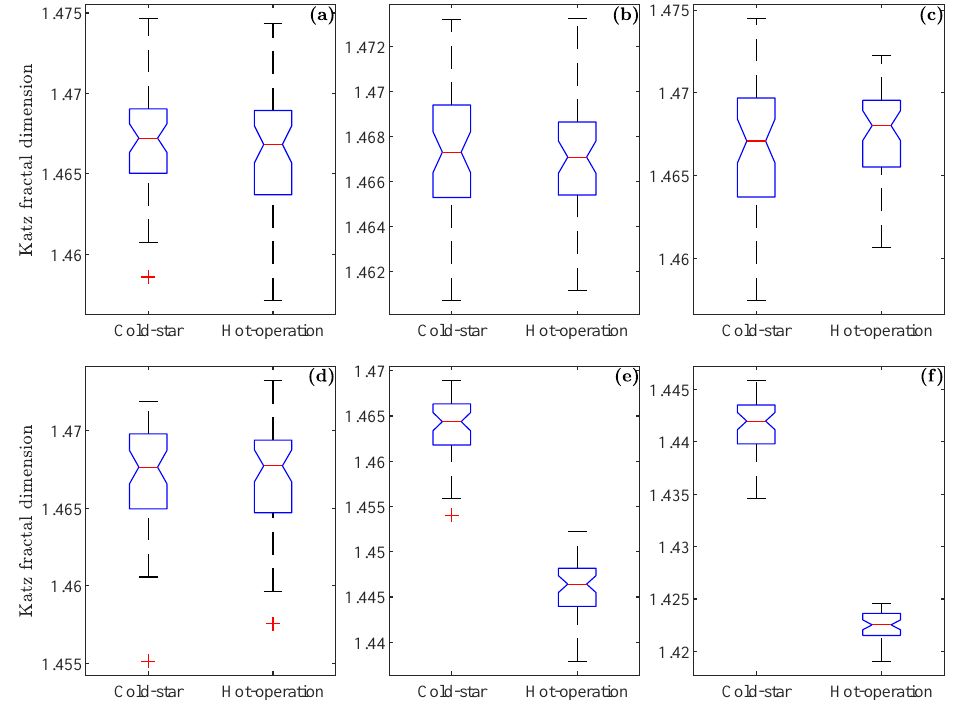
Figure 10. The Katz fractal dimension values from the “cold-start” and “hot-operation” datasets, corresponding to a noise level of 5 dB for level 1 detail: ( a – c ) set of values for joints 1 to 3; ( d – f ) set of values for joints 4 to 6.